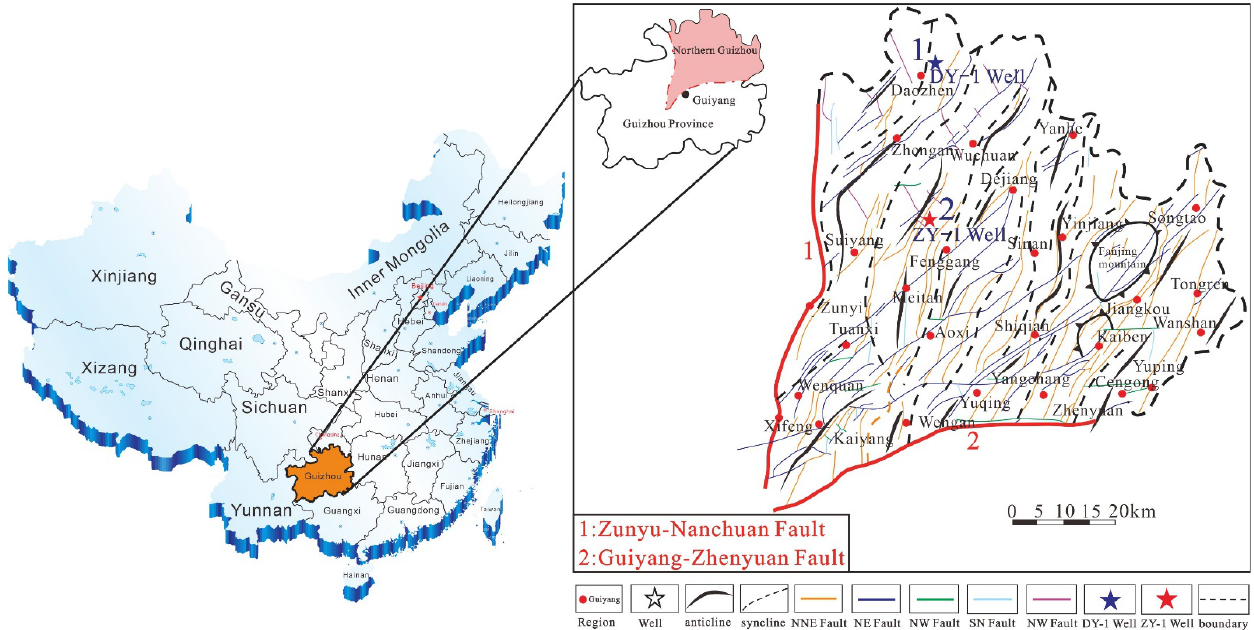
Figure 1. Tectonic outline map of northern Guizhou Province (modified after